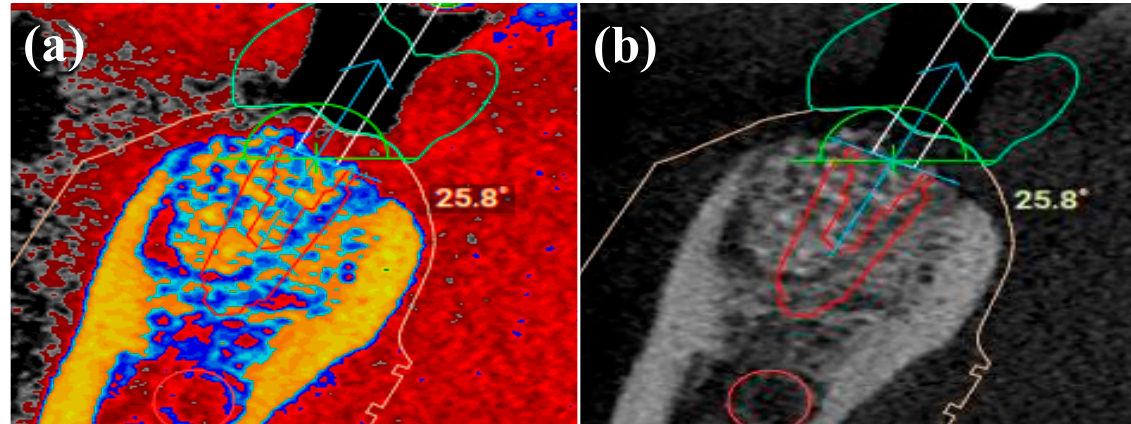
Figure 1. ( a ) Different HU values were used to create a colour map and ( b ) to identify different structures. Bone is represented as yellow and soft tissue as red. This allowed the inferior alveolar nerve IAN to be traced accurately.